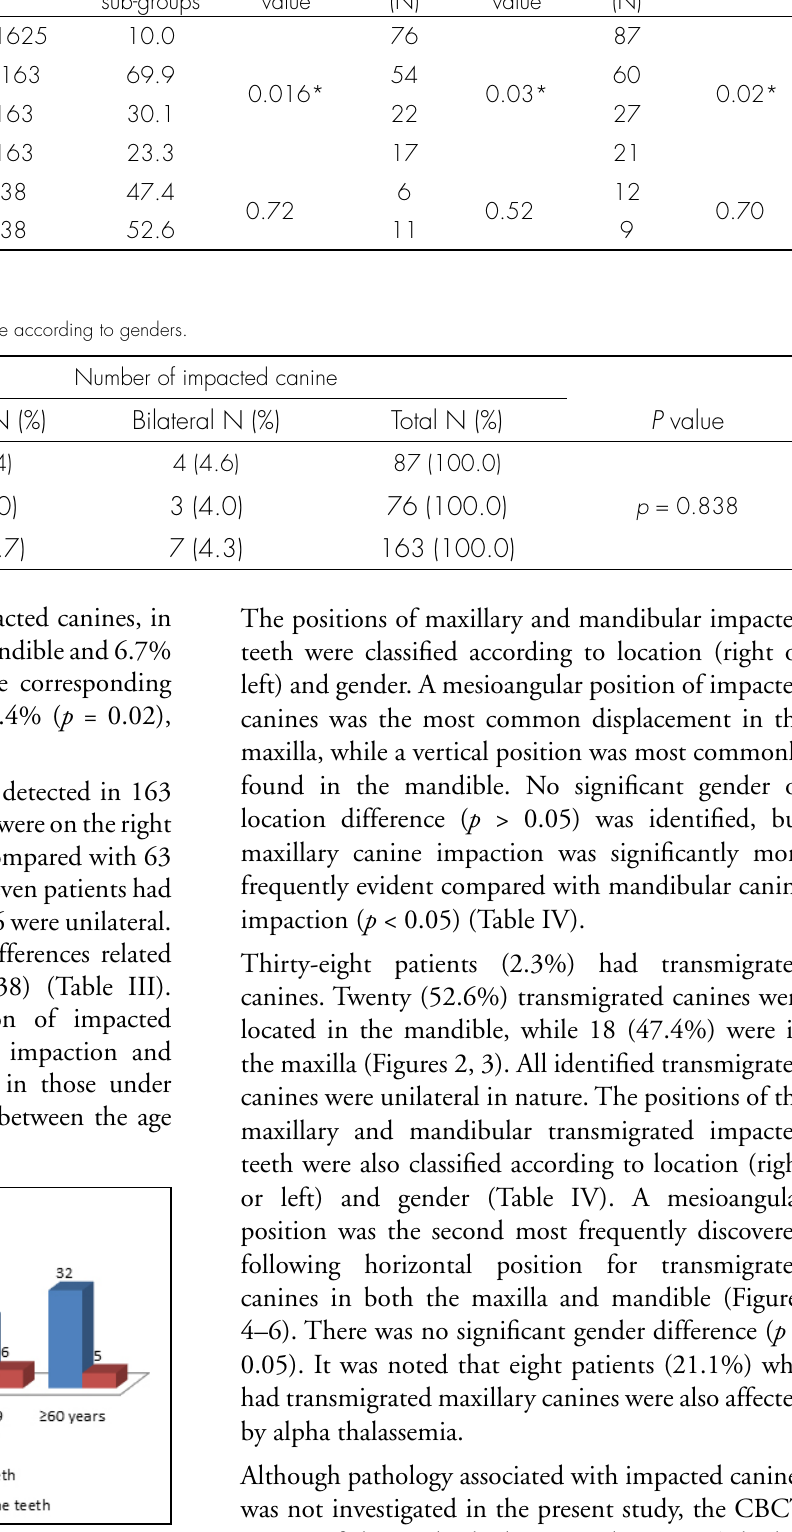
Figure 1. The distribution of impacted and transmigrated canine teeth.